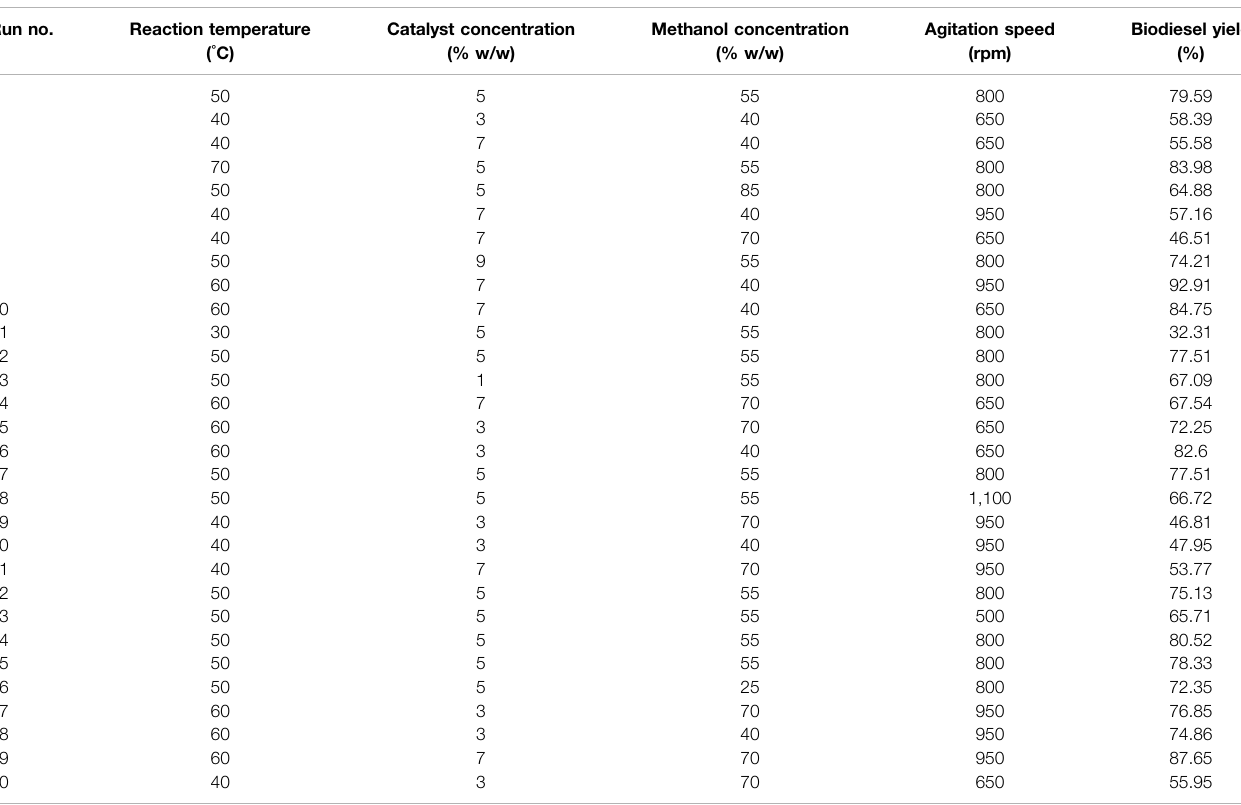
TABLE 2 | CCD experimental design matrix for optimization Run